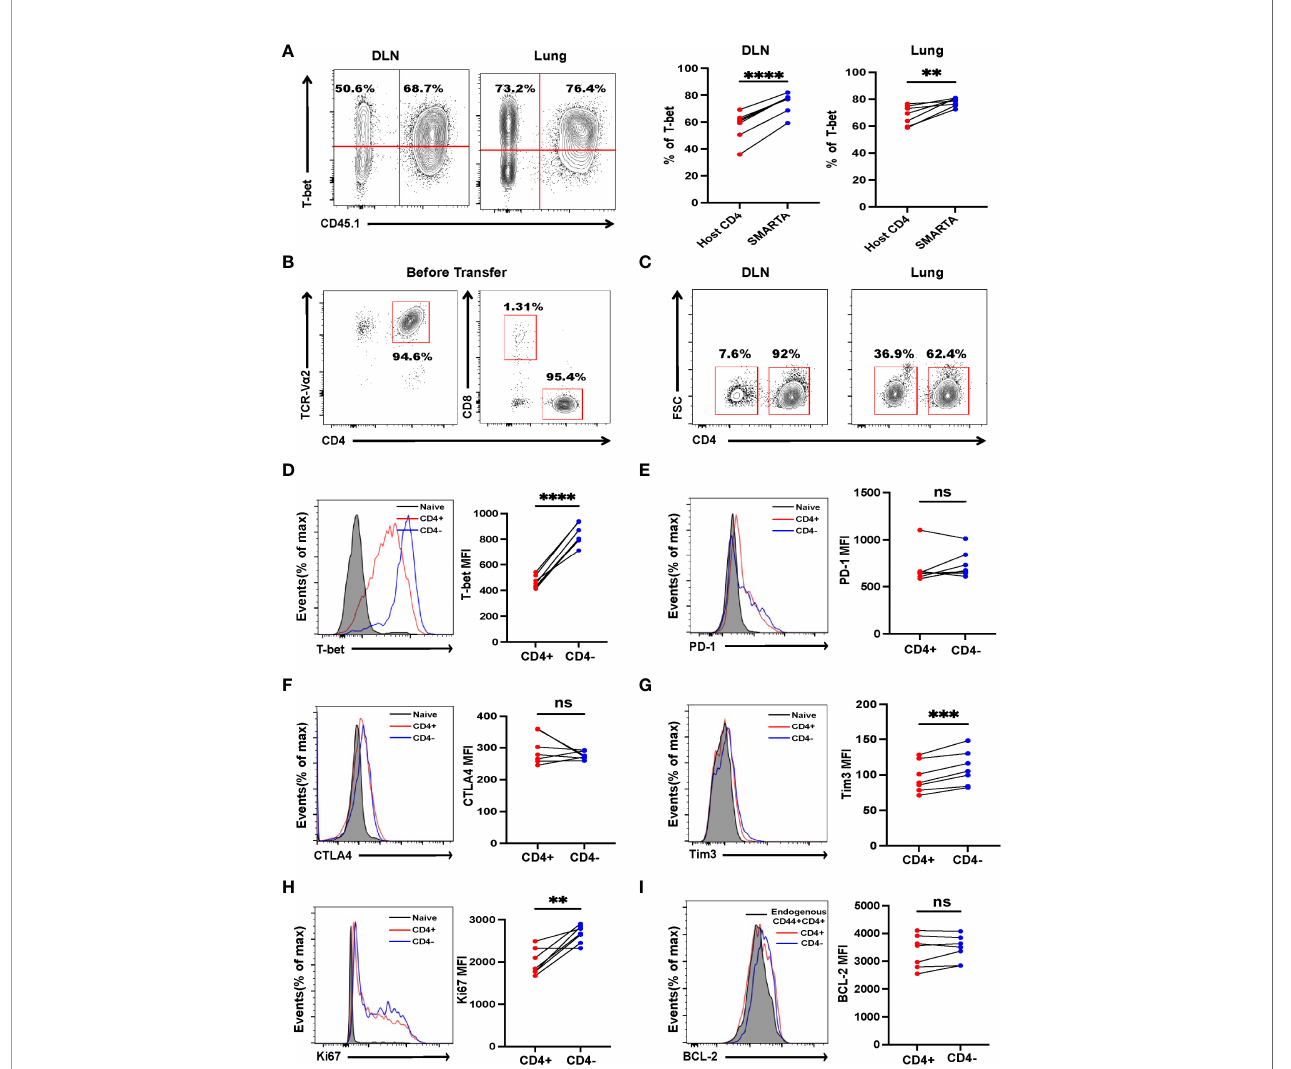
FIGURE 2 | Tumor-speci fi c CD4 + T cells differentiate into Th1 and CD4 - T cells. B16-GP tumor-bearing C57BL/6J mice were adoptively transferred with 2 × 10 6 activated SMARTA cells on Day 8 after tumor inoculation and sacri fi ced seven days later. (A) Left panel: representative fl ow cytometry plots of T-bet expression in CD4 + T cells in draining lymph node (DLN) and lung tissue (Lung). Cells are gated on live CD44 + CD4 + T cells. The numbers are percentages of cells accounting for CD45.1 - (left quadrant) and CD45.1 + (right quadrant) populations. Right panel: the statistical analysis of percentages of T-bet positive cells as shown in the left panel (n=7/group). (B) The purity of the activated SMARTA cell before transfer. (C) Representative fl ow cytometry plots of CD4 + and CD4 – SMARTA cells in the DLN and lung and cells are gated on live CD45.1 + cells. Numbers are frequencies of indicated populations (n=7/group). (D-I) Flow cytometry analyses of SMARTA cells isolated from the lung comparing the expression level of T-bet, PD-1, CTLA4, Tim3, Ki67 and BCL-2 between CD4 + and CD4 - SMARTA cells. The mean fl uorescent intensities (MFIs) are summarized beside. Cells are gated on live CD45.1 + cells (n=7/group). Statistical differences are calculated by paired student ’ s t test. ns, not signi fi cant, ** p < 0.01, *** p < 0.001, **** p <